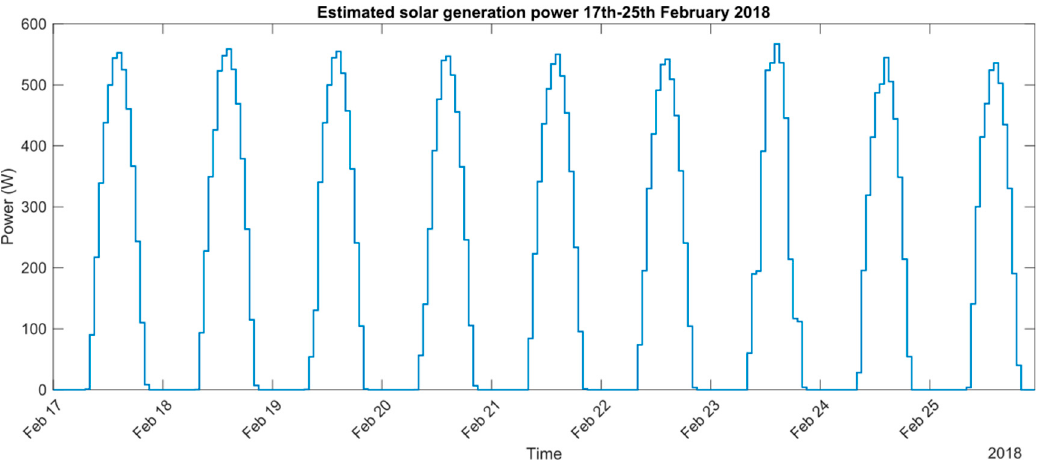
Figure 12. Estimated solar generation power from February 17th to 25th 2018.